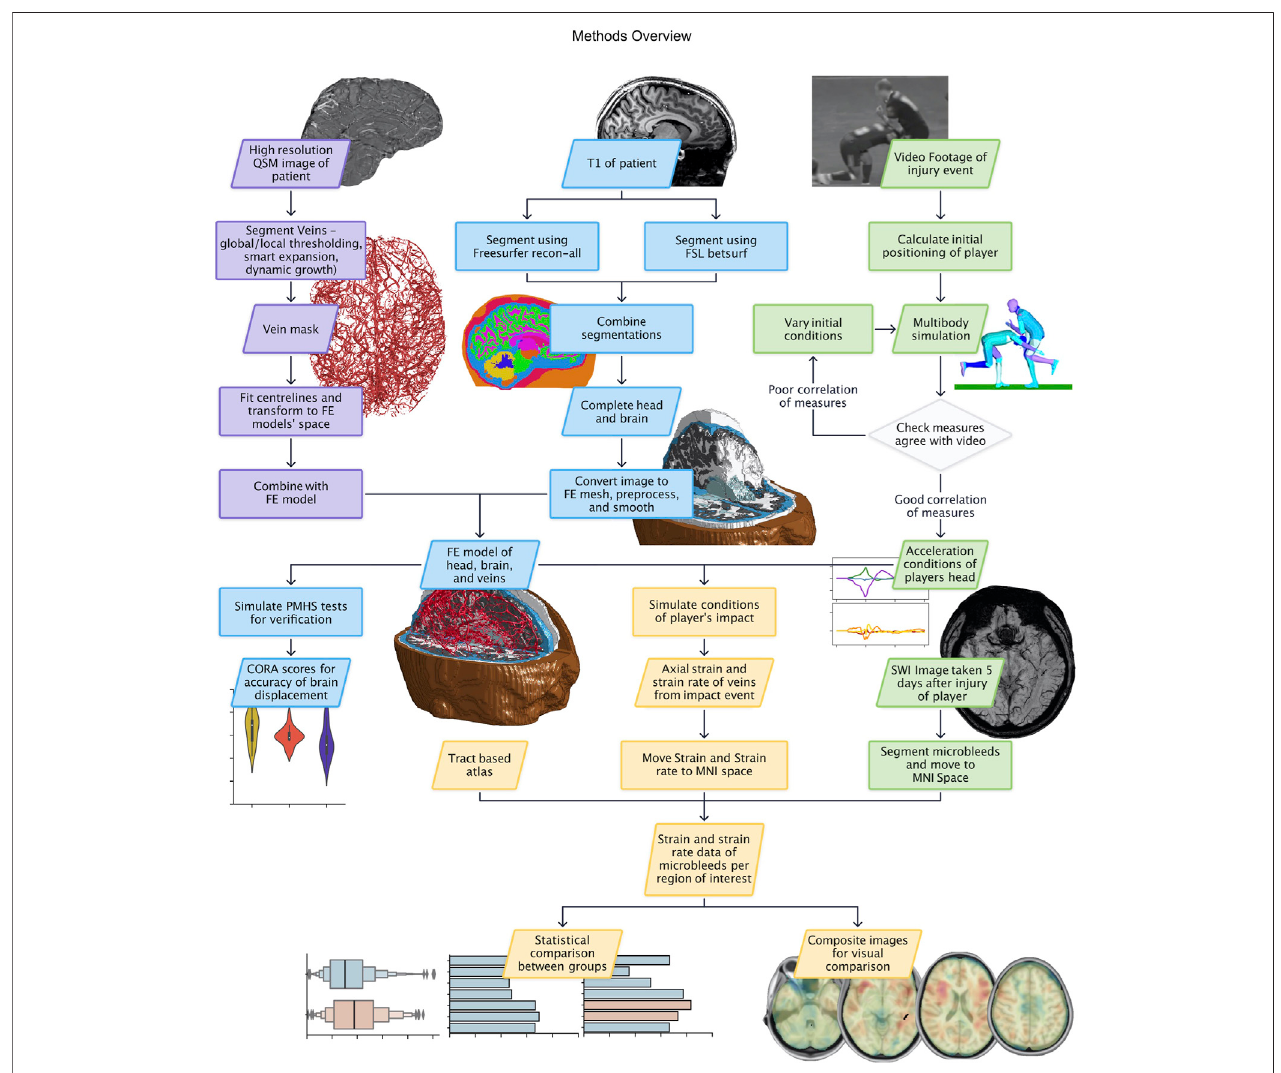
FIGURE 1 | Methods fl owchart with data and process boxes coloured according to their theme: vein segmentation in purple, FE model creation in blue, reconstruction in green, and results in yellow.